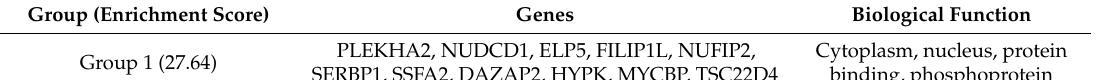
Table 4. Functional classification of genes regulated by a group of four miRNAs, including hsa-miR-21, hsa-miR-203, hsa-miR-22 and hsa-miR-143, which are highly correlated with PKCs. Group (Enrichment